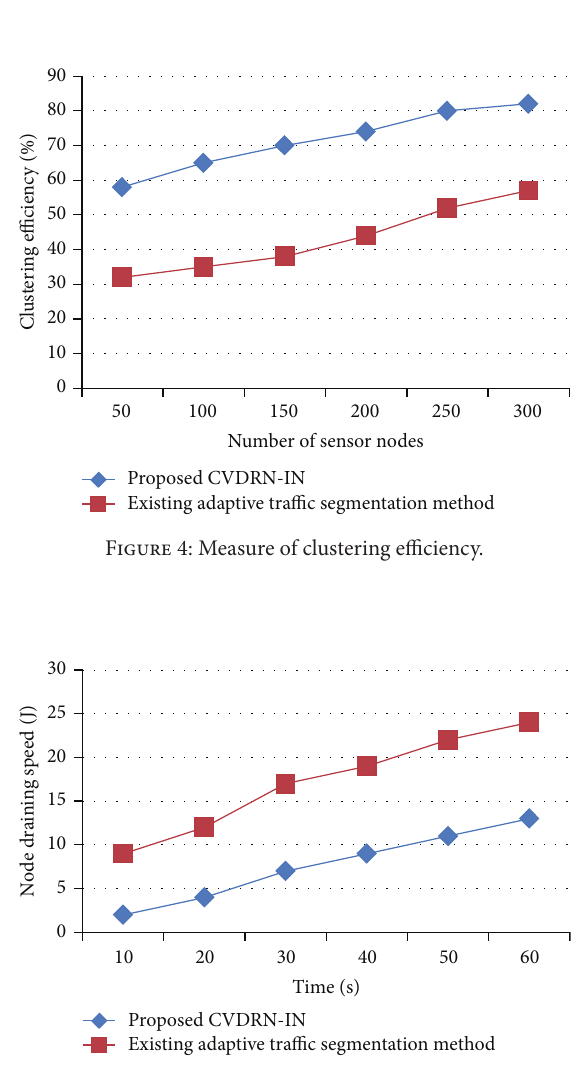
Figure 5: Measure of node draining